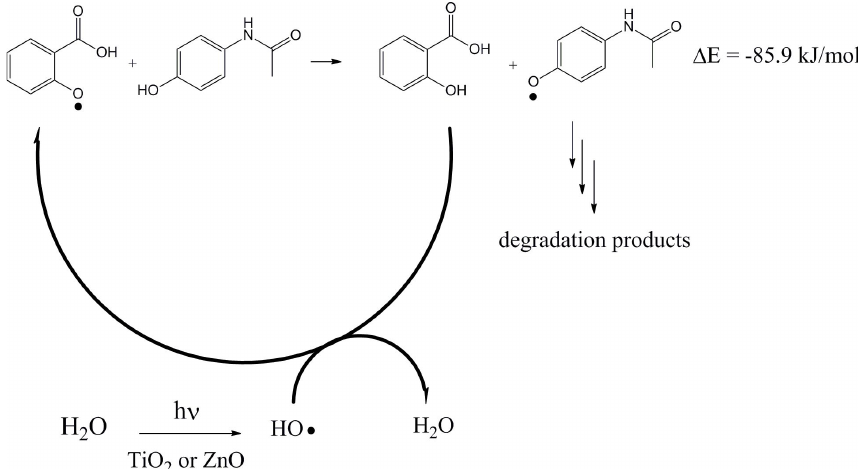
or ZnO-catalysed photodegradation of paracetamol. The energies 2